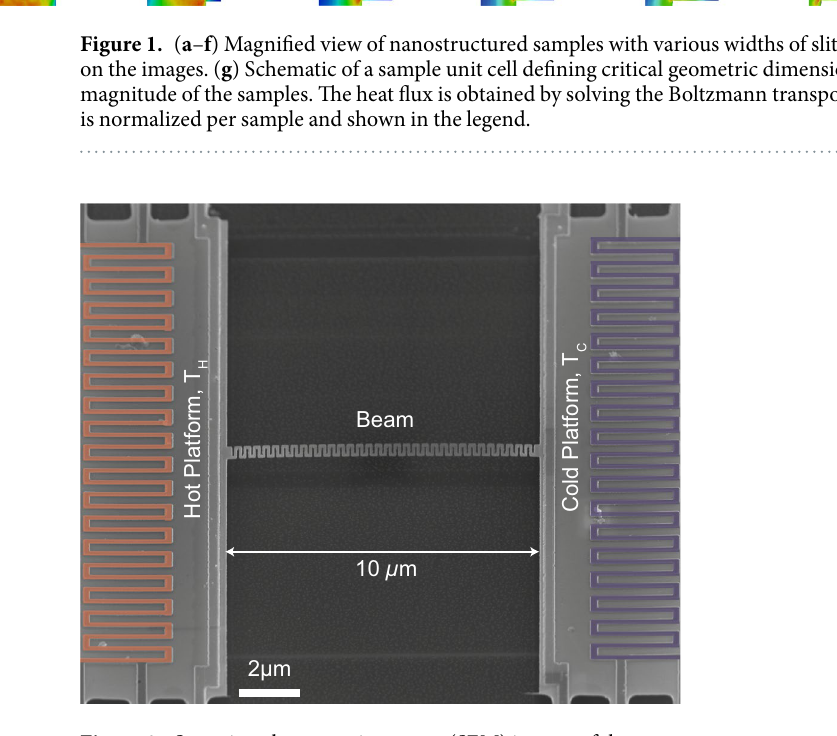
Figure 2. Scanning electron microscope (SEM) images of the measurement structure with false-colored serpentine heater/thermometers. The SEM image is rotated by 45 degrees about the major beam axis. The residual shadow below the beam confirms that it is fully suspended over the